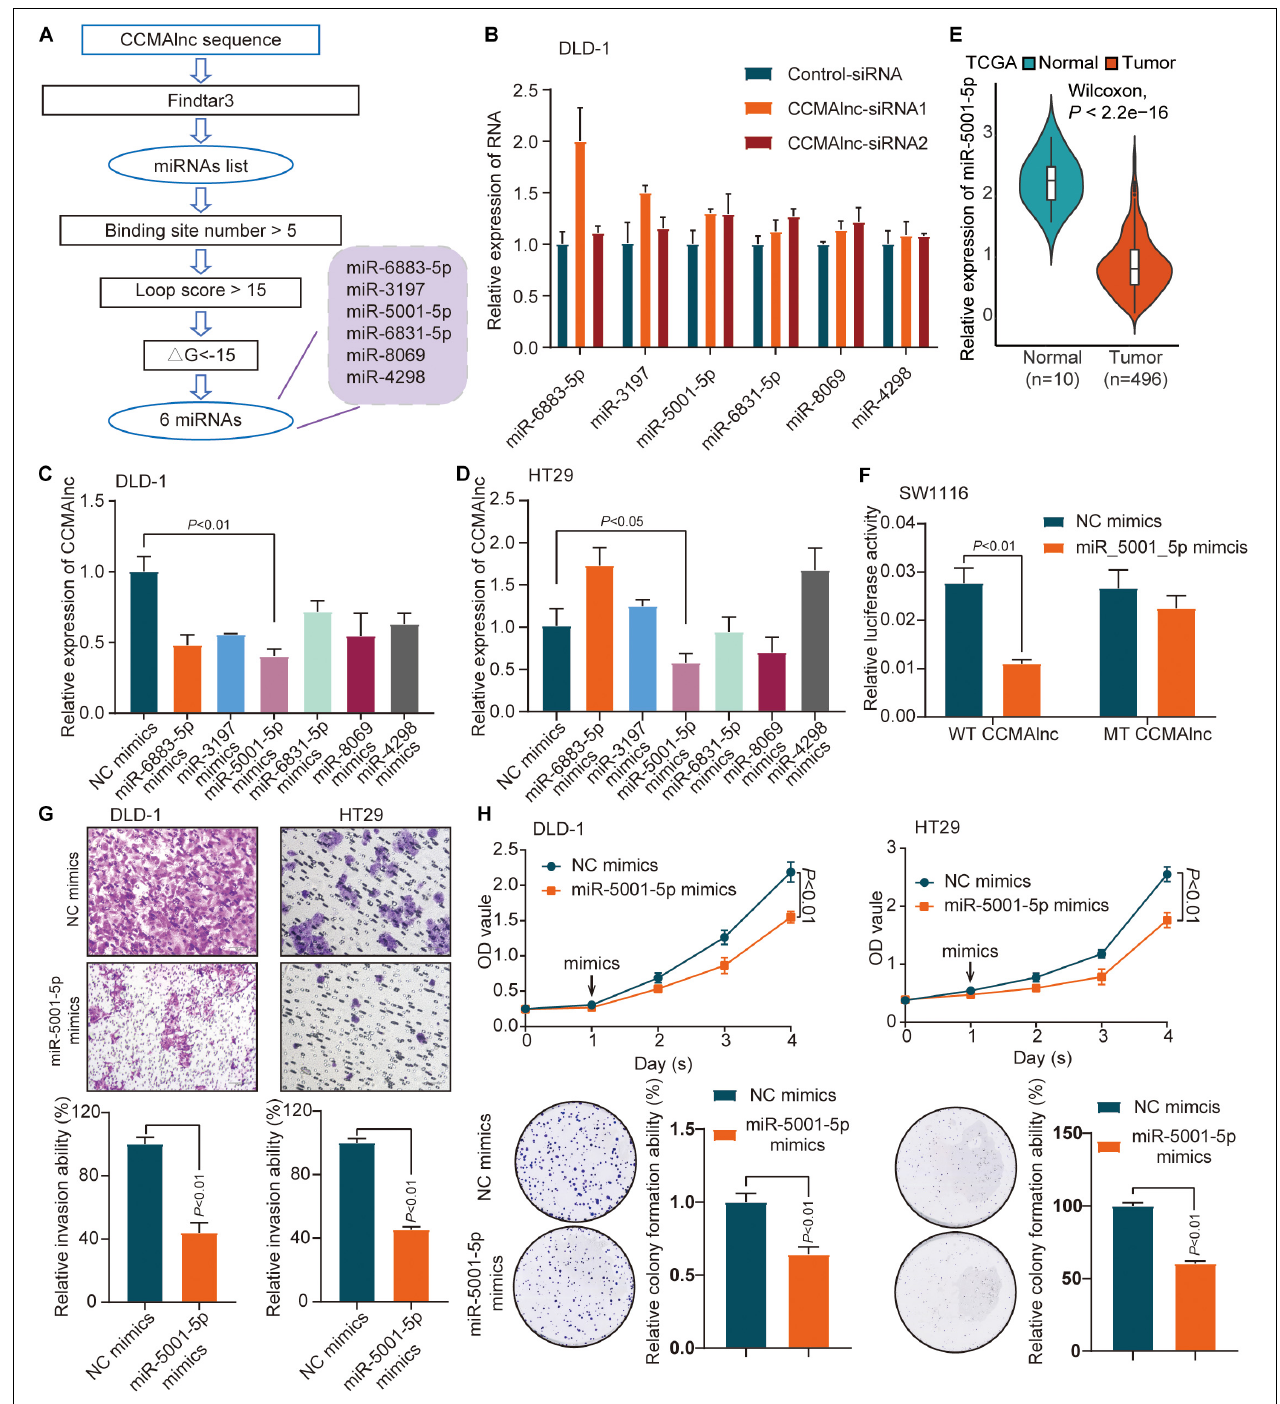
FIGURE 3 | Identification of miR-5001-5p as a target of CCMAlnc. (A) Flowchart of CCMAlnc targeted miRNA screening. (B) The expression of candidate microRNAs after transfection with CCMAlnc siRNA 1 and siRNA 2. (C,D) The expression of CCMAlnc when transfected with candidate microRNA mimics in DLD-1 (C) and HT29 (D) cells. (E) The expression of miR-5001-5p in normal and CRC tissues in the TCGA database. (F) Luciferase reporters containing CCMAlnc or CCMAlnc-mutant were cotransfected into SW1116 cells with miR-5001-5p mimics. Luciferase activities were detected after 48 h. (G) Invasion of DLD-1 and HT29 cells was reduced by miR-5001-5p. The invading cell numbers on each filter were counted. Data were plotted by defining the percentage of control mimics-transfected cells as 100%. N = 3. Scale bars, 50 mm. (H) miR-5001-5p reduced cell proliferation and anchorage-dependent growth, as detected by CCK8 proliferation and colony formation assays in DLD-1 and HT29